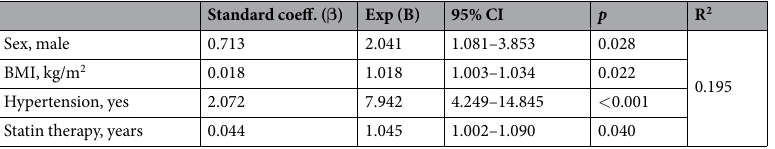
Table 5. Factors associated with the presence of type 2 diabetes mellitus in genetically-defined heterozygous familial hypercholesterolemia patients (with a pathogenic mutation in LDLR , APOB or PCSK9 genes ). BMI denotes body mass index. Independent variables included in the model: sex, age, BMI, smoking status, hypertension, tendon xanthomas, baseline LDL and HDL cholesterol and triglyceride concentrations, genetic diagnosis and statin therapy